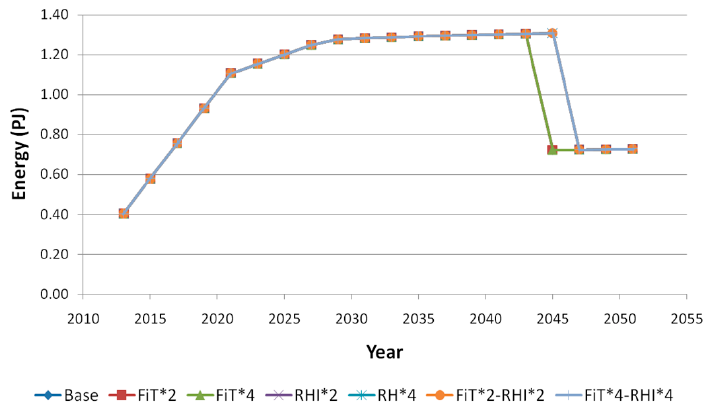
Figure 11. Lowlands farms—biogas production.